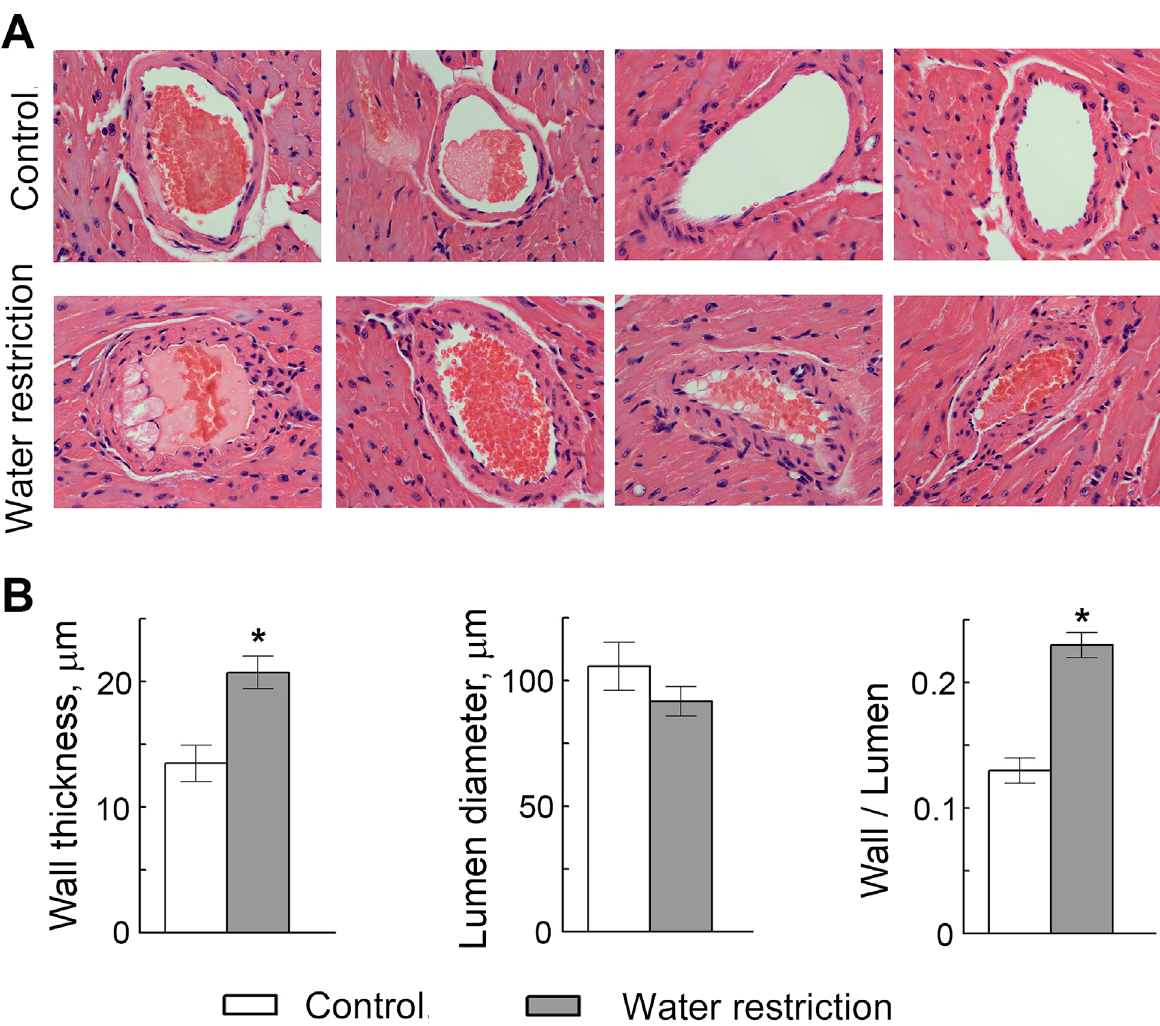
Fig 5. Water restriction causes thickening of the walls of coronary arteries in ApoE -/- mice. (A) Representative images from hematoxylin and eosin staining of heart sections showing coronary arteries. (B) Quantification of the arterial wall thickness, lumen diameter and wall thickness to lumen diameter ratio. Data are presented as mean ± SEM, * P < 0.05, N = 7.